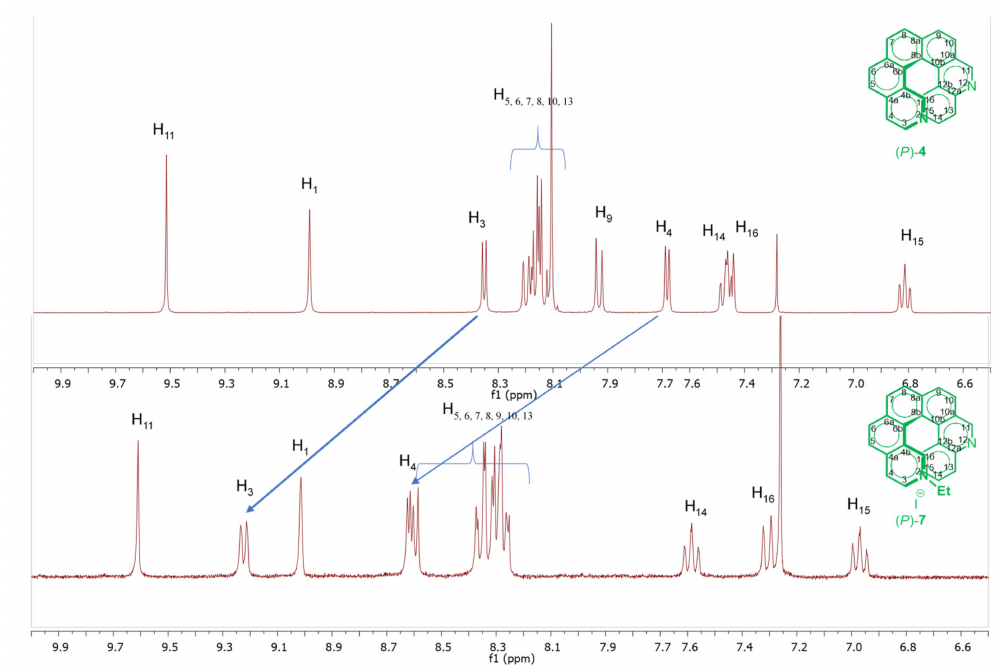
Figure 6. Comparison of 1 H-NMR spectra of 4 and 7